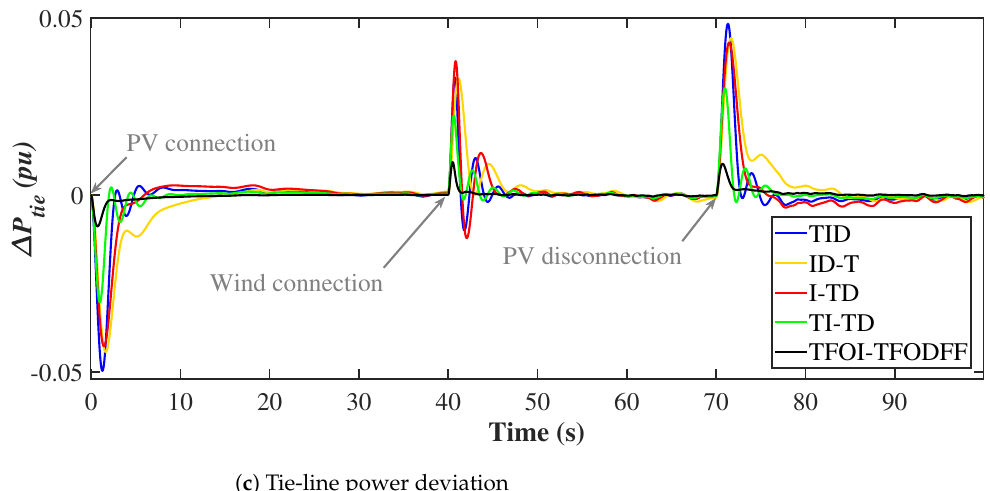
Figure 17. The dynamic response of the system to scenario